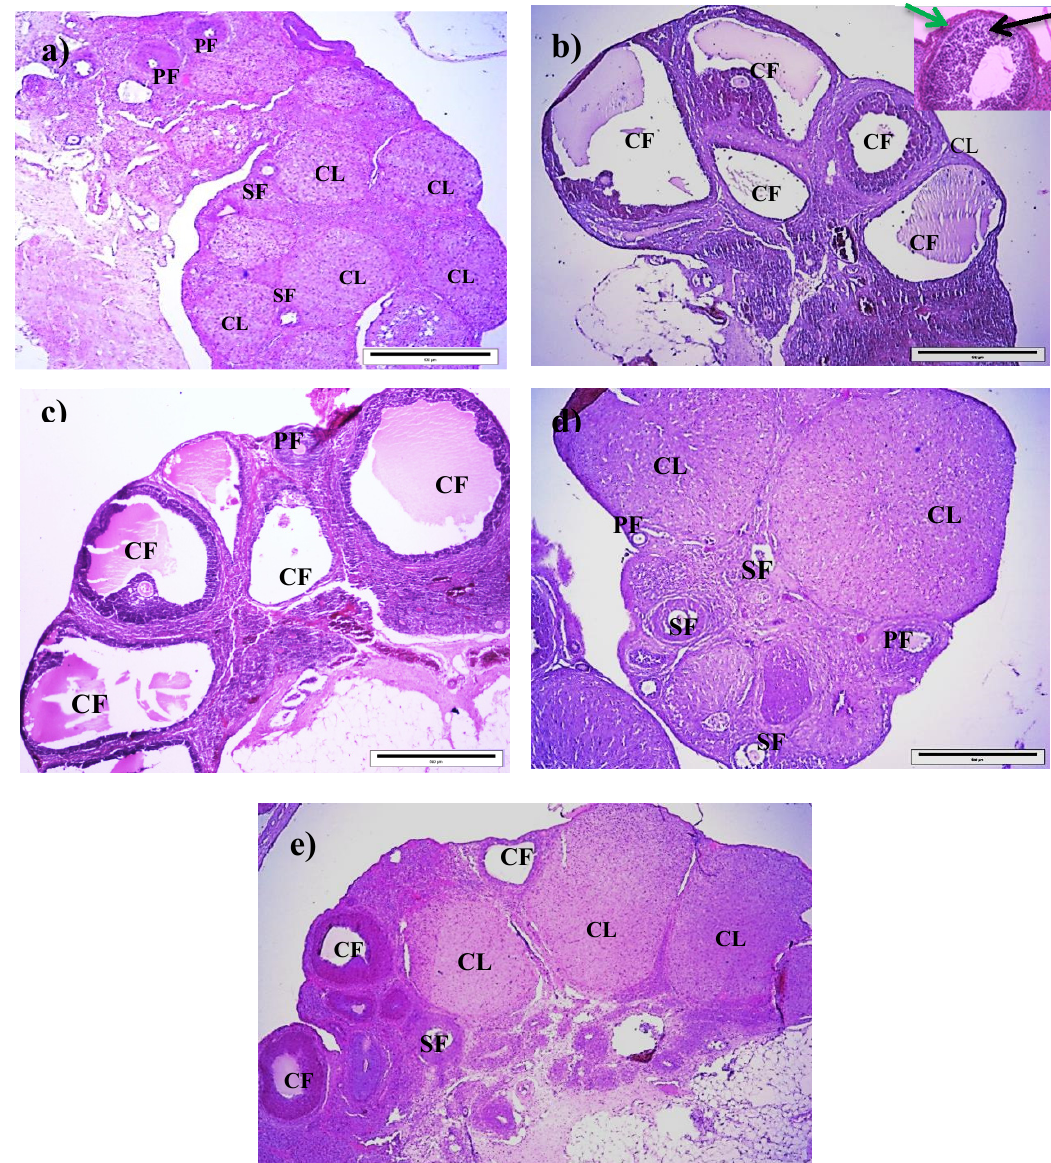
Figure 2. Representative photomicrograph of rat ovary showing normal follicular development with the presence of CLs, PFs, and SFs in control group ( a ), large CFs lining by thick theca cells (black arrow) and thin granulosa cells (green arrow) were predominant in T group ( b ), and T+100RJ group ( c ), while small CFs were observed in the T+400RJ group ( e ). However, in the T+200RJ group ( d ), these abnormal changes were improved. T: testosterone, RJ: royal jelly, CL: corpus luteum, CF: cystic follicle, PF: primary follicle, SF: secondary follicle. Photographs were taken using 40X (scale bar = 50 µm) objectives.